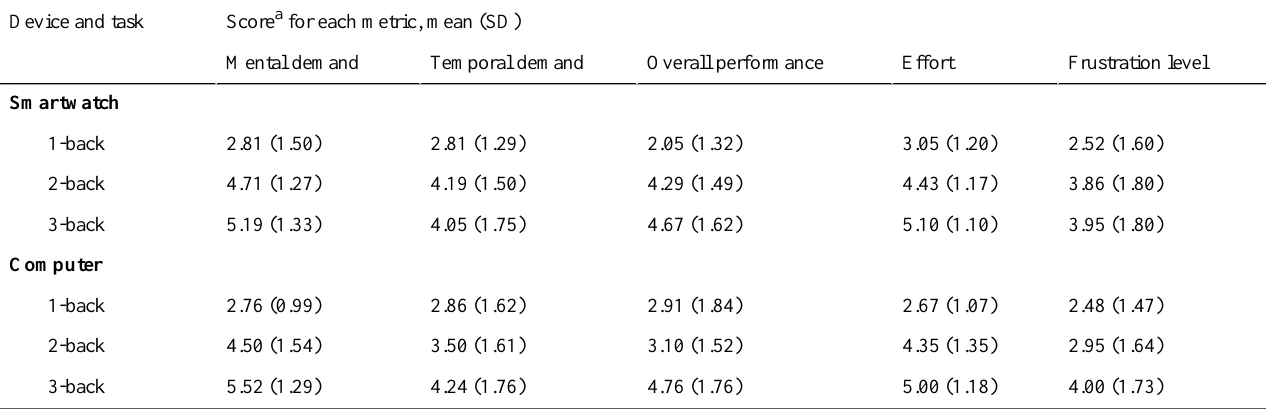
Table 3. The N-back cognitive workload results using the NASA-TLX (Task Load Index) metrics. Score a for each metric, mean (SD)Device and